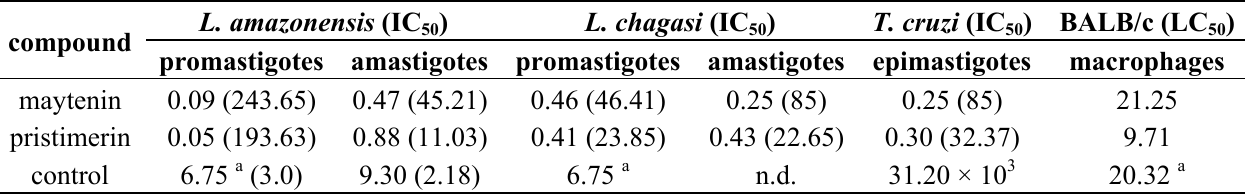
Table 1. Leishmanicidal, trypanocidal and cytotoxic activities of maytenin ( 1 ) and pristimerin ( 2 ) in nanomolar.